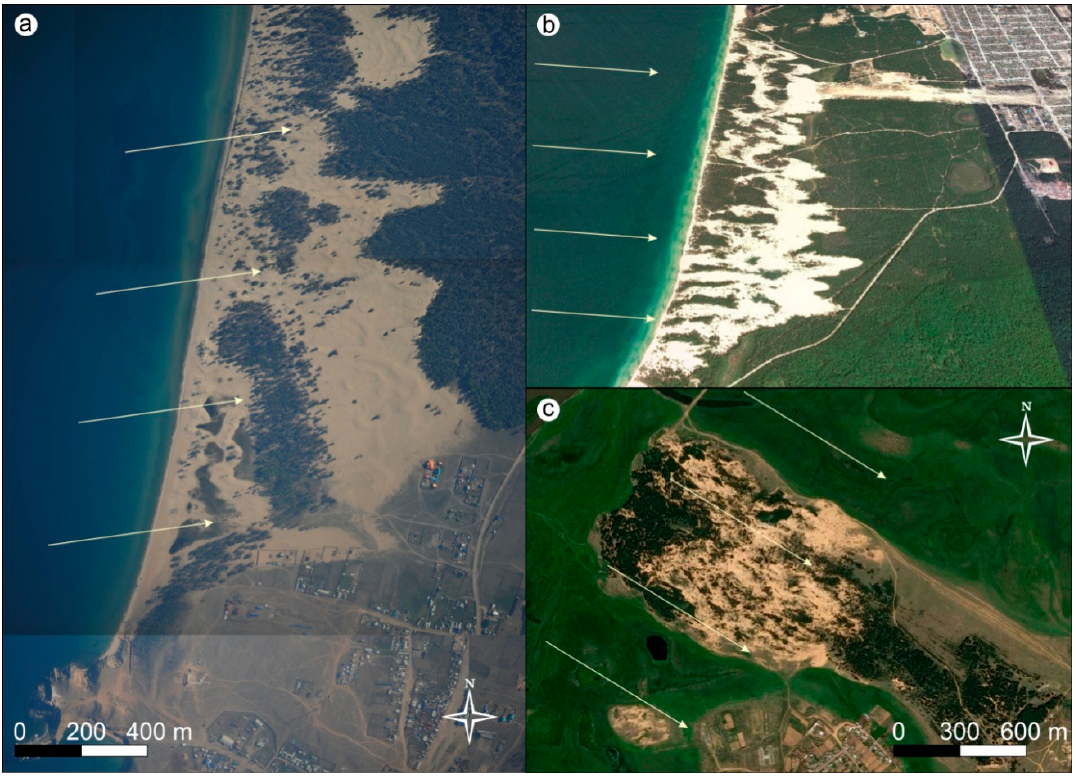
Figure 3. Drift sands of the Baikal region: ( a )—western coast of Ol’khon Island (photo by the Cosmonaut Training Center, 2014); ( b )—near the mouth of the Barguzin river (electronic resource www.bing.com/maps#); ( c )—the Selenga river delta (Baranii cape, 2018).